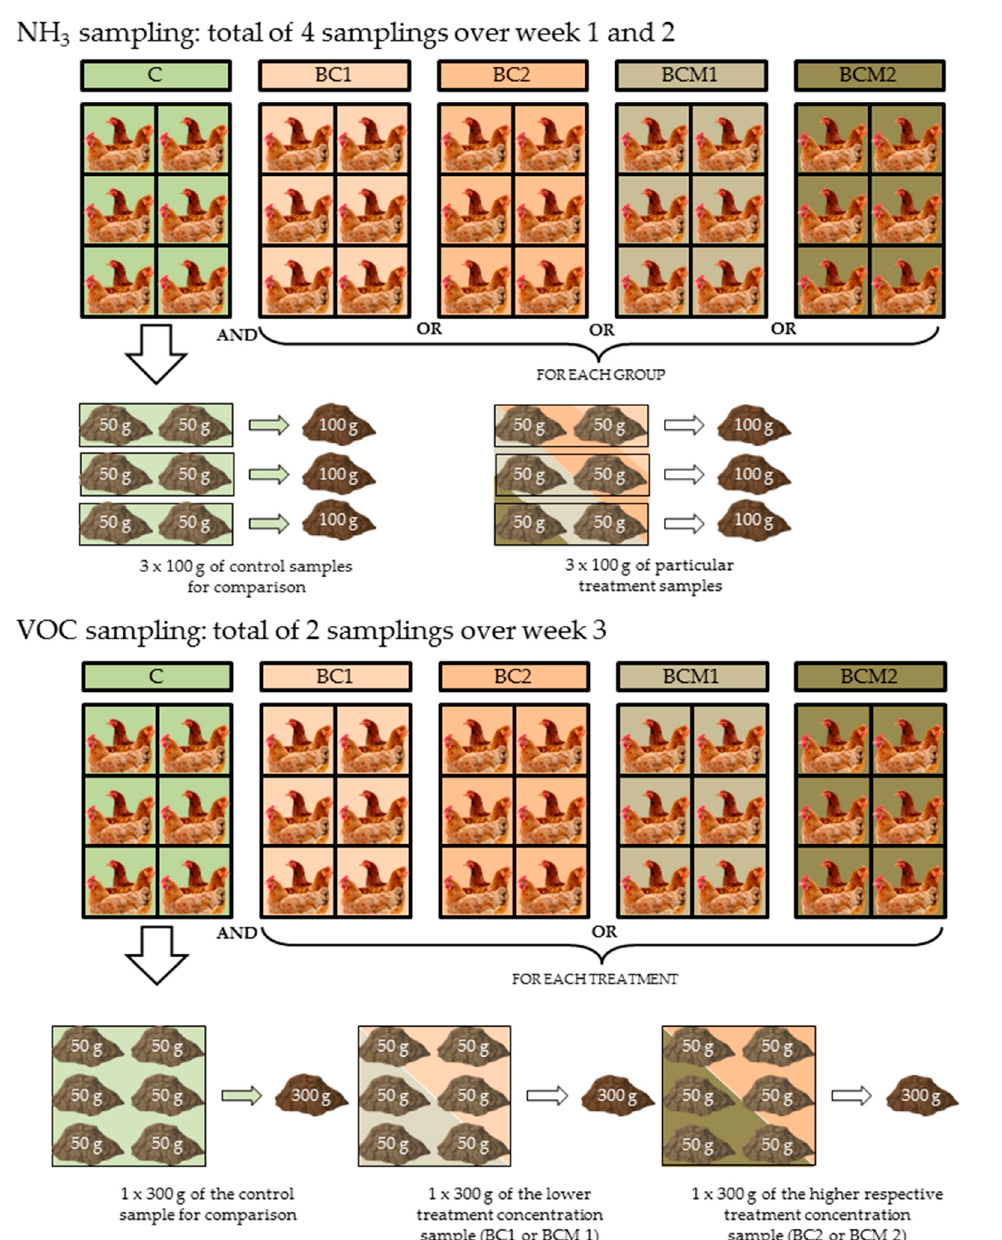
Figure 1. Visualization of the excreta sampling process.